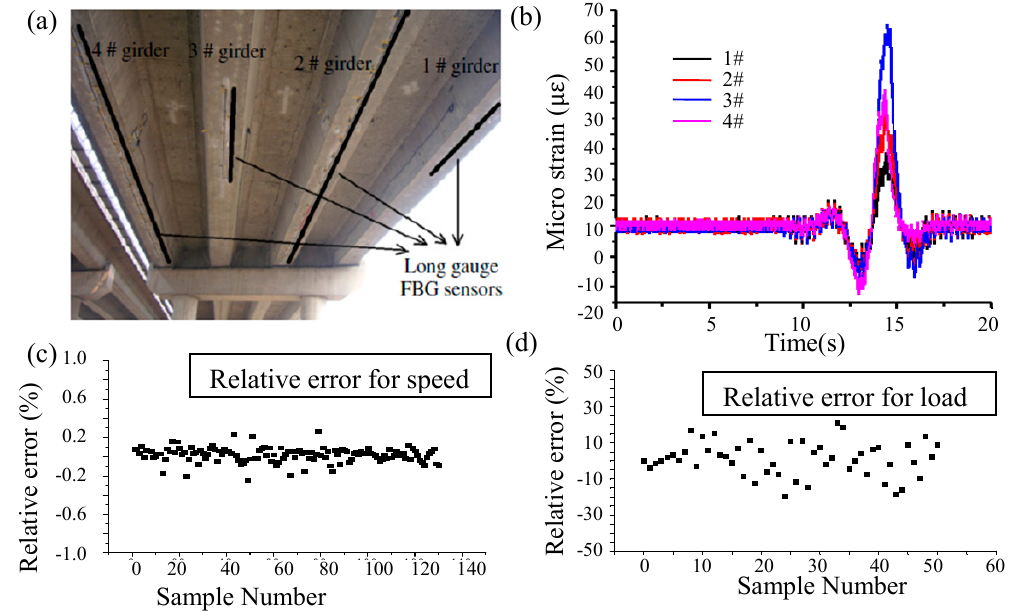
Figure 12. Load application to a continuous beam bridge: ( a ) Sensor installation; ( b ) Typical long gauge strains; ( c ) Relative error for speed; ( d ) Relative error for load [72].